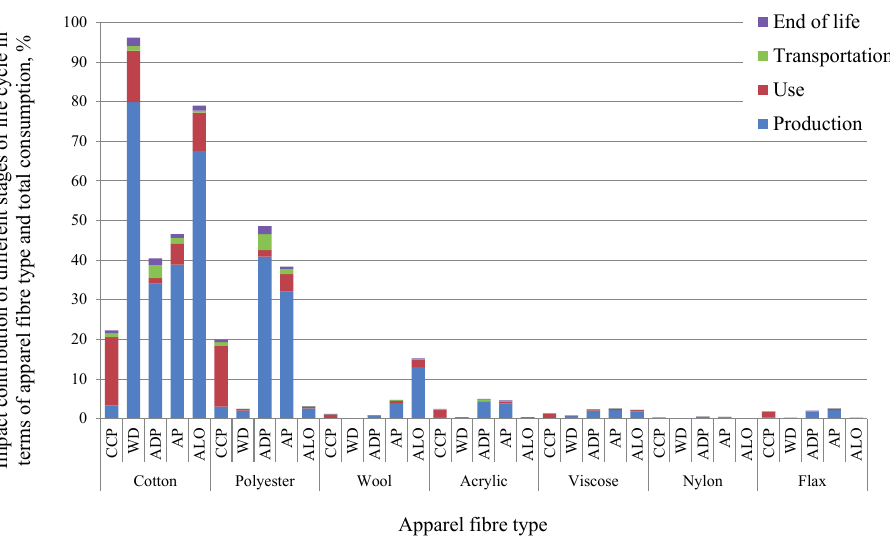
Fig. 10. Change of impact contribution per capita-year from 2008 to 2018.